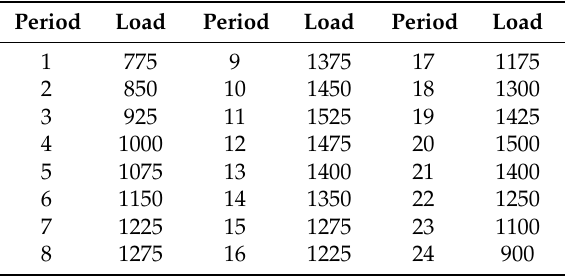
Table 2. A typical day’s system load data (MW).